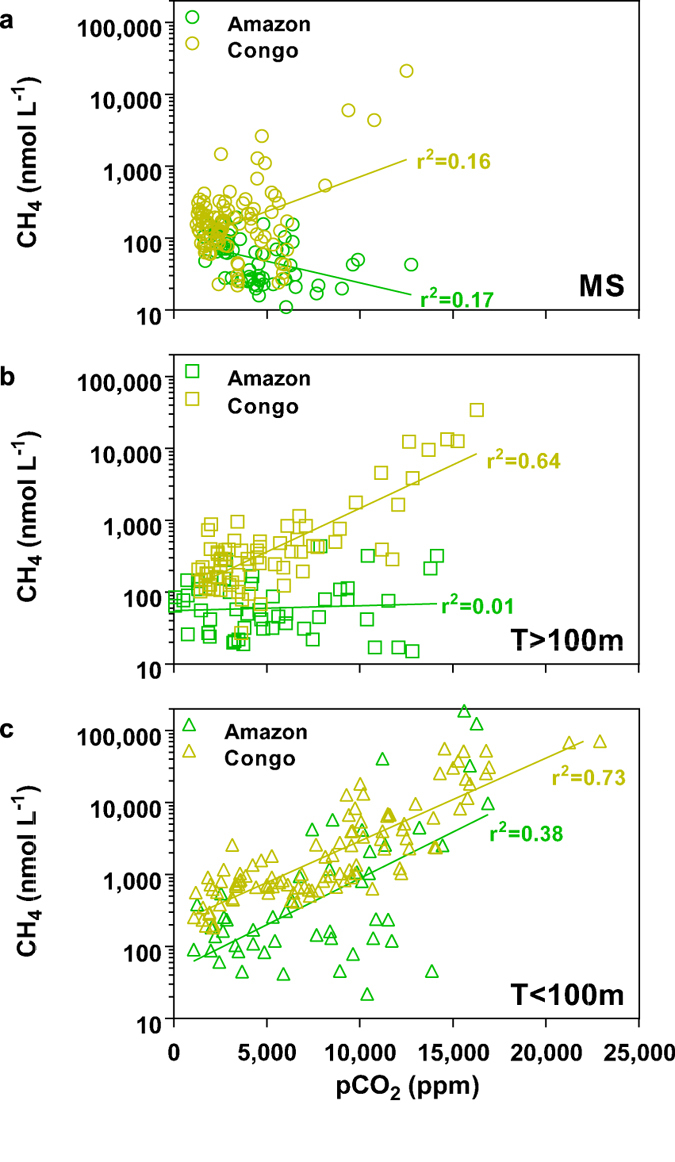
Log of CH4 concentration as function of pCO2 in the mainstem (MS) (a), the large tributaries (T > 100 m) (b), and small tributaries (T < 100 m) (c) of the Amazon and Congo basins.Lines correspond to the linear regressions of log transformed CH4 as a function of pCO2.